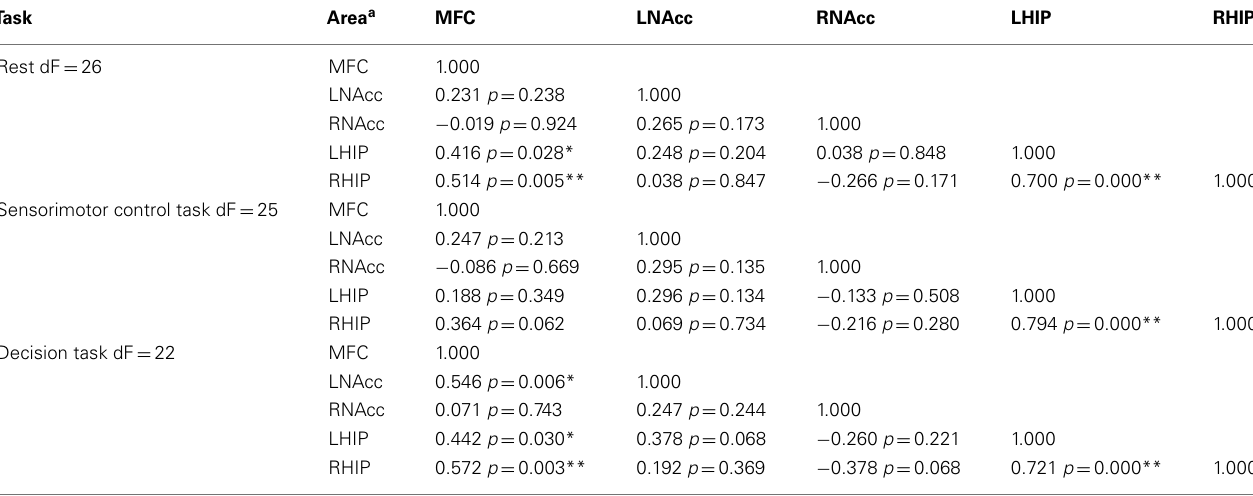
Table 7 | Functional connectivity between regions of interest during three task conditions at baseline.